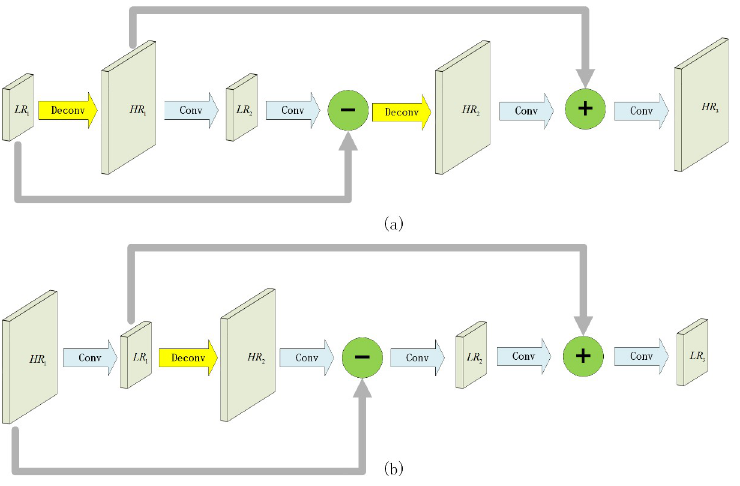
Fig 4. Deep-projection deconvolution model. (a) is up projection unit. (b) is down projection unit.